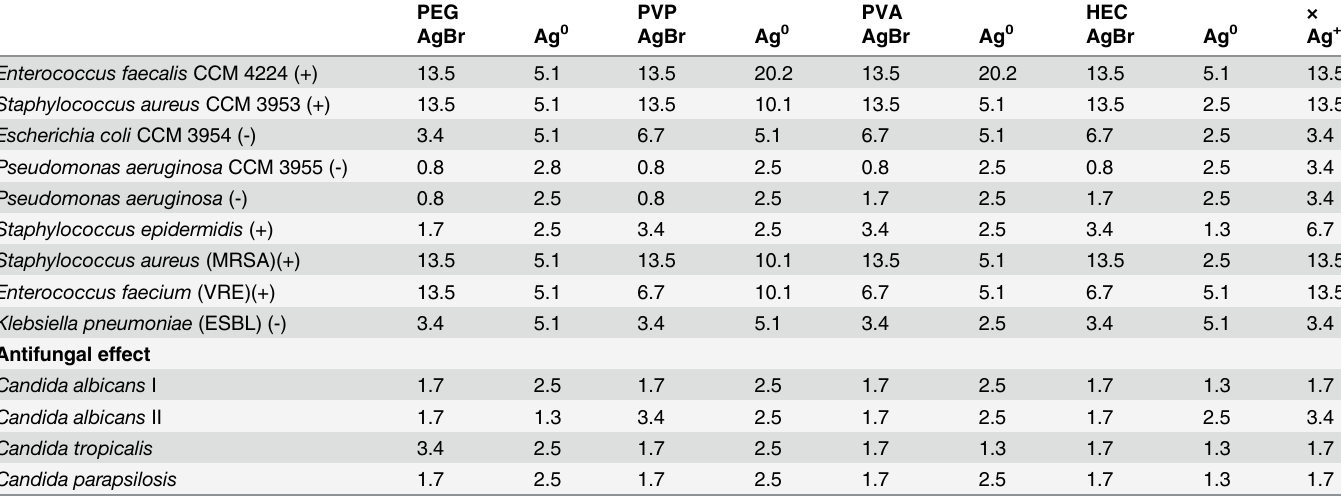
Antibacterial and antifungal activities of the prepared AgBr and Ag NPs were tested on 9 strains of bacteria and 4 strains of candida. Table 3 shows the obtained experimental data in the form of minimum inhibitory concentrations (MIC) that were recalculated on the total Table 3. Minimum inhibitory concentrations (mg/L) of silver bromide nanoparticles, silver nanoparticles and ionic silver against gram-positive (+) and gram-negative (-) bacteria and against yeast pathogens recalculated on total silver concentration prepared in the presence of selected